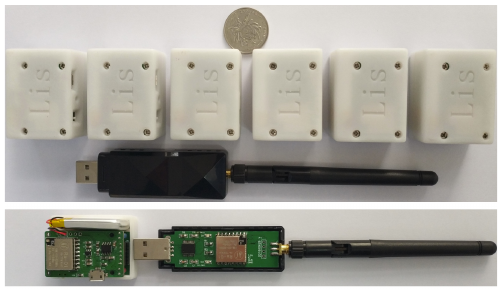
Figure 1. The device appearance and its disassembled prototype of the self-made inertial sensor-based motion capture.